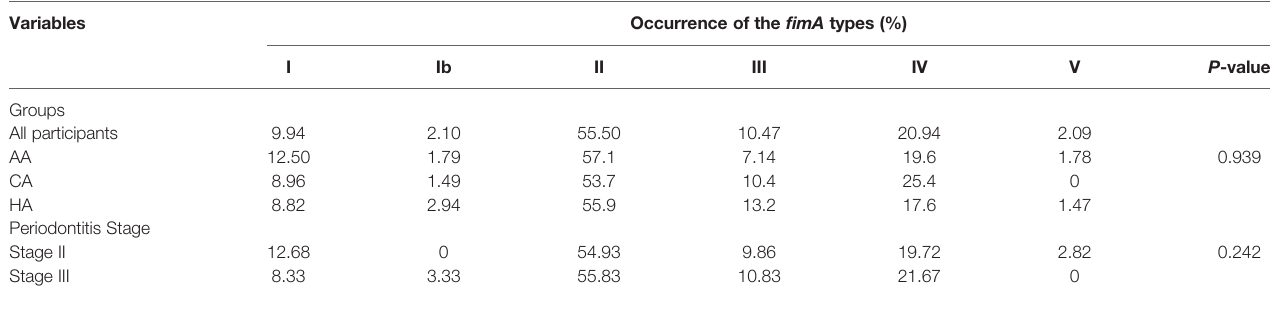
TABLE 5 | Distribution of P. gingivalis fi mA types in periodontitis patients.